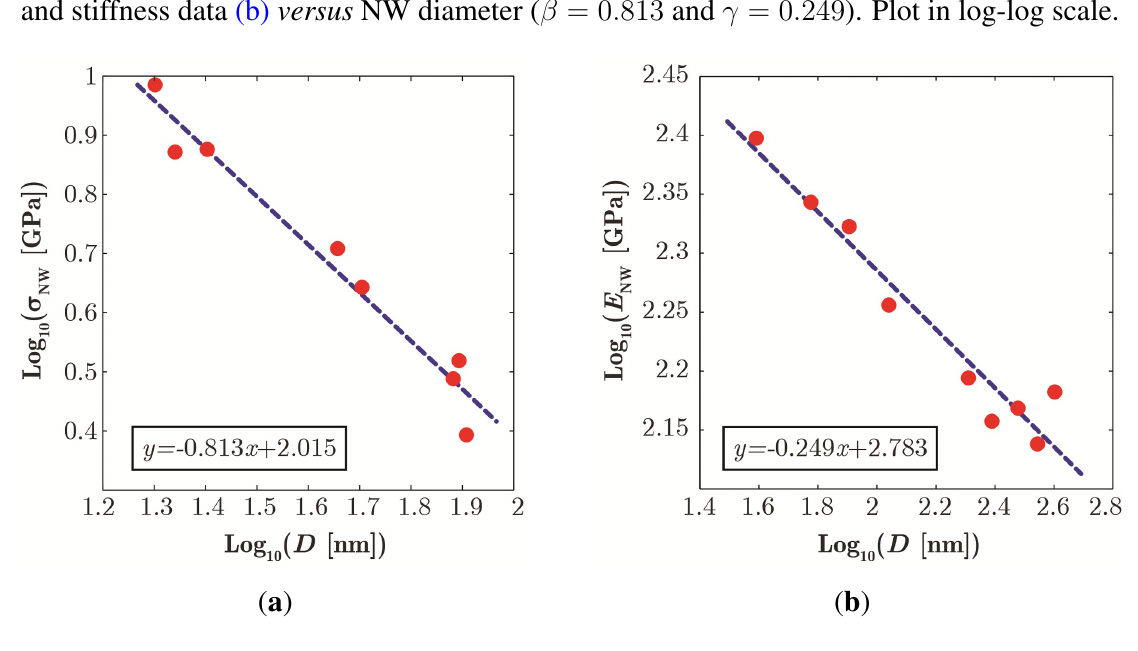
Figure 4. The agreement between experimental data [8] and power-law fit for failure data (a) and stiffness data (b) versus NW diameter ( β = 0 . 813 and γ = 0 . 249 ). Plot in log-log